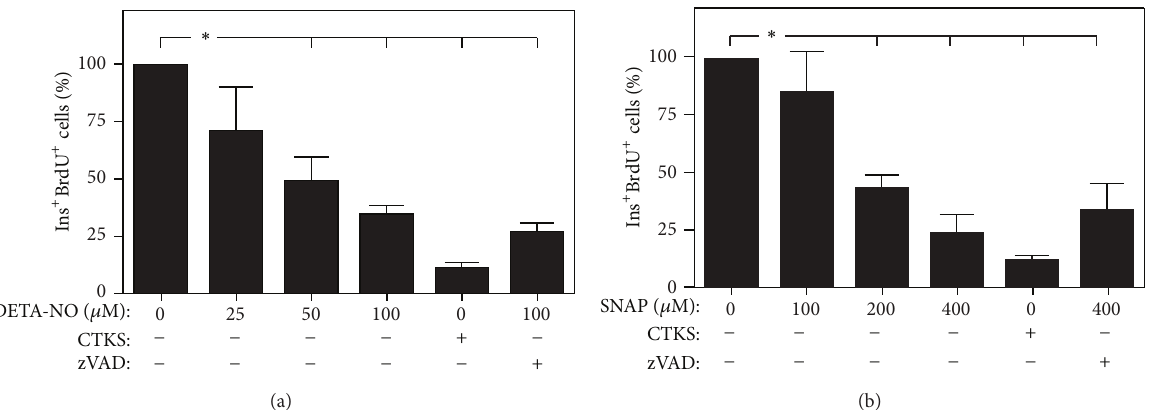
Figure 1: Effect of NO donors in cultured beta cell proliferation. Rat islets were cultured for 48 h and treated with NO donors DETA-NO (a) and SNAP (b) at increasing concentrations, alone or in combination with zVADfmk (100 𝜇 M), a caspase inhibitor, and with the combination of proinflammatory cytokines IL-1 𝛽 (50 U/mL) + IFN- 𝛾 (1000U/mL) + TNF- 𝛼 (1000U/mL) (CTKS). Cultures were stained with BrdU over the course of the culture period. Bar graphs are percentage means ± SEM of accumulated BrdU/insulin-positive cells over the culture period relative to insulin-positive cells. Values are the means of 4 experiments. ∗ 𝑃 < 0.05 treated versus control.